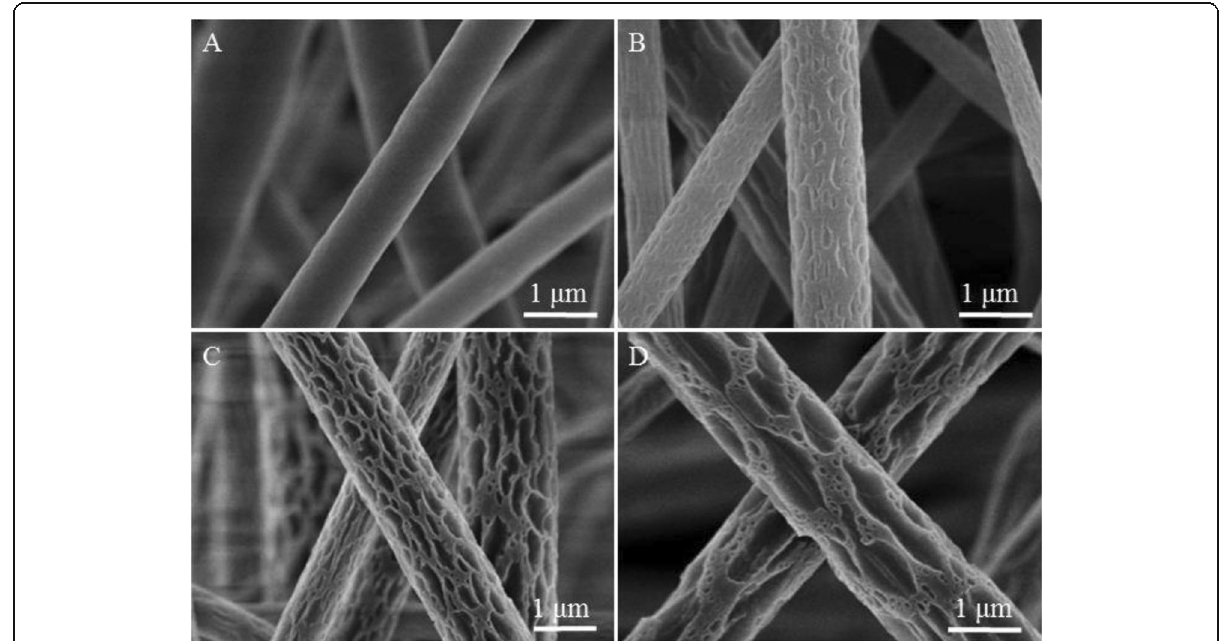
Fig. 1 Representative SEM images of samples fabricated by electrospinning 18% ( w / v ) PVDF solution from ACE at different levels of relative humidity. a 5%, b 25%, c 45%, and d